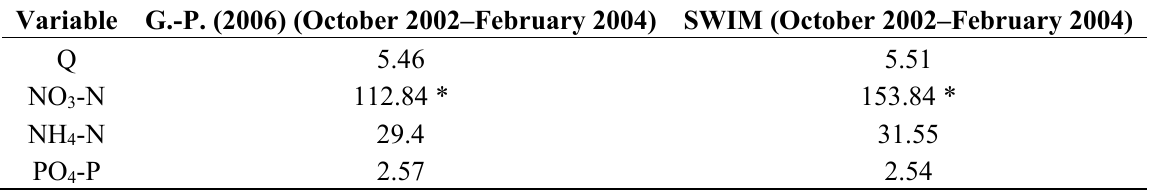
Table 3. Comparison of simulated and estimated (Garcia-Pintado et al. [18]) average annual total inflow (Q) and nutrients (NO 3 -N, NH 4 -N and PO 4 -P) input from the Albujon catchment (including the diversion from Rambla de la Maraña) to the Mar Menor.